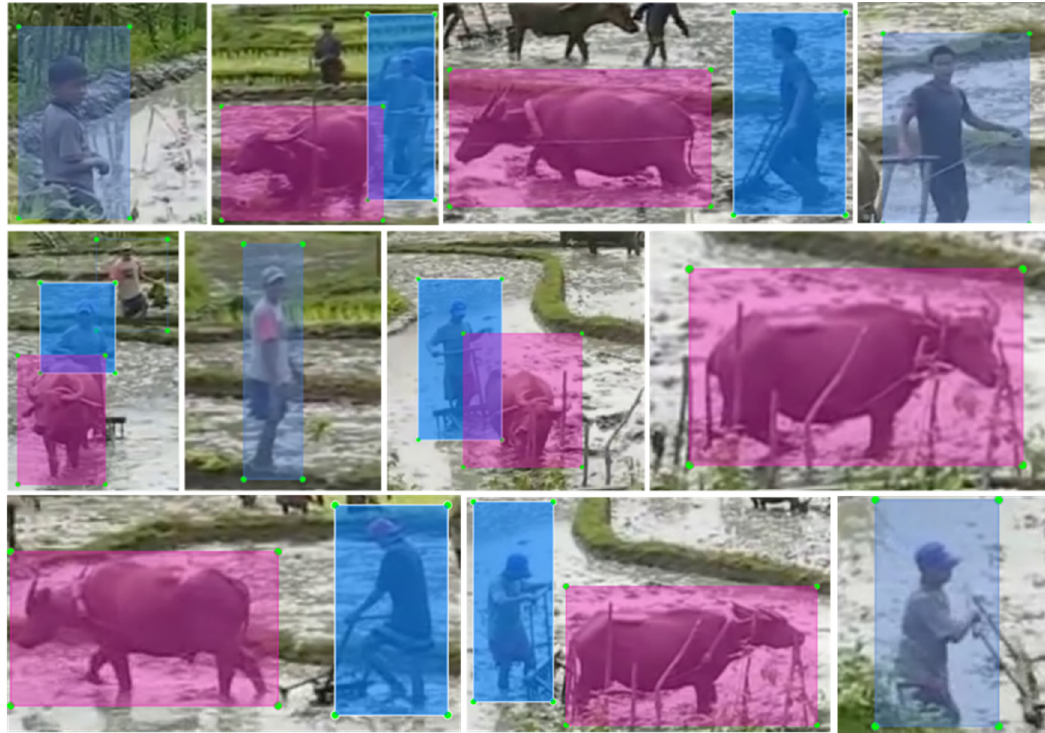
Figure 8. Parts of images in the test set. The pink and blue rectangles are self-labeled ground truths. The pink rectangles are ground truths for water buffaloes, the blue ones are for humans. Table 3. Performance comparison of standard Yolov3 and improved Yolov3 on test